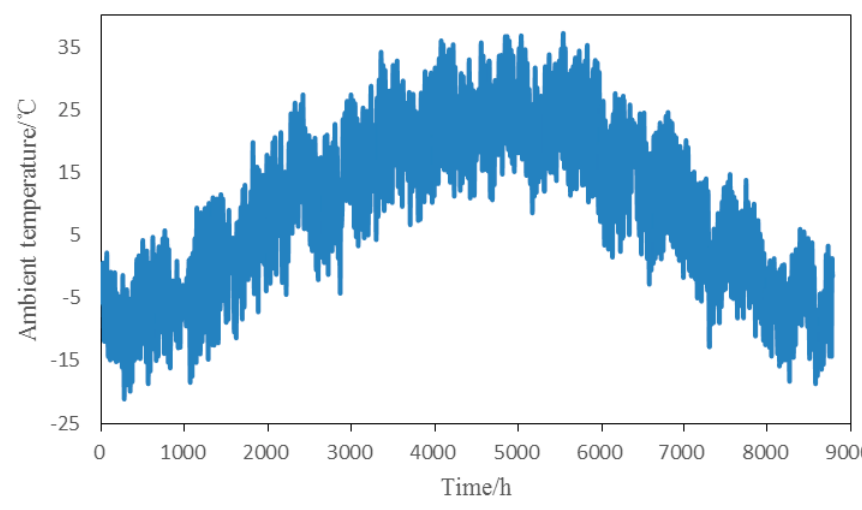
Figure 6. The ambient temperature data of Dunhuang over a typical year.